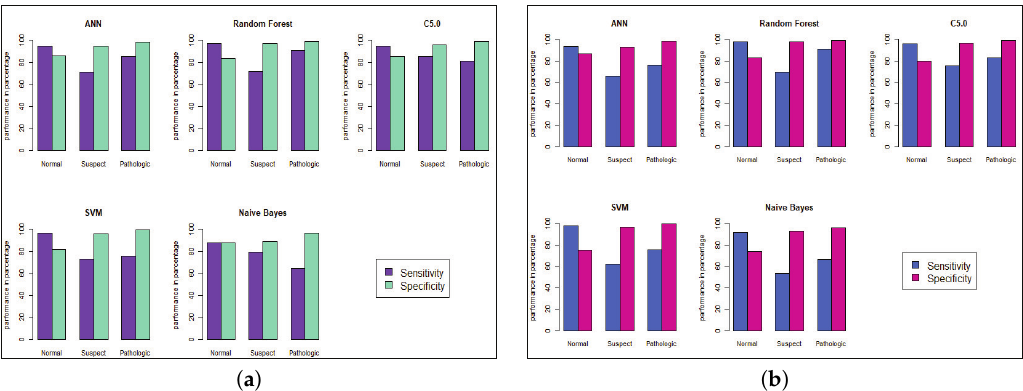
Figure 7. Model Performance of sensitivity and specificity for CTG prediction. ( a ) Before Genetic Algorithm. ( b ) After Genetic